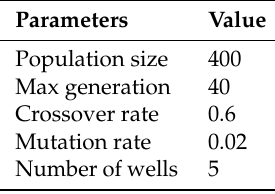
Table 1. The parameters of genetic algorithm (GA).